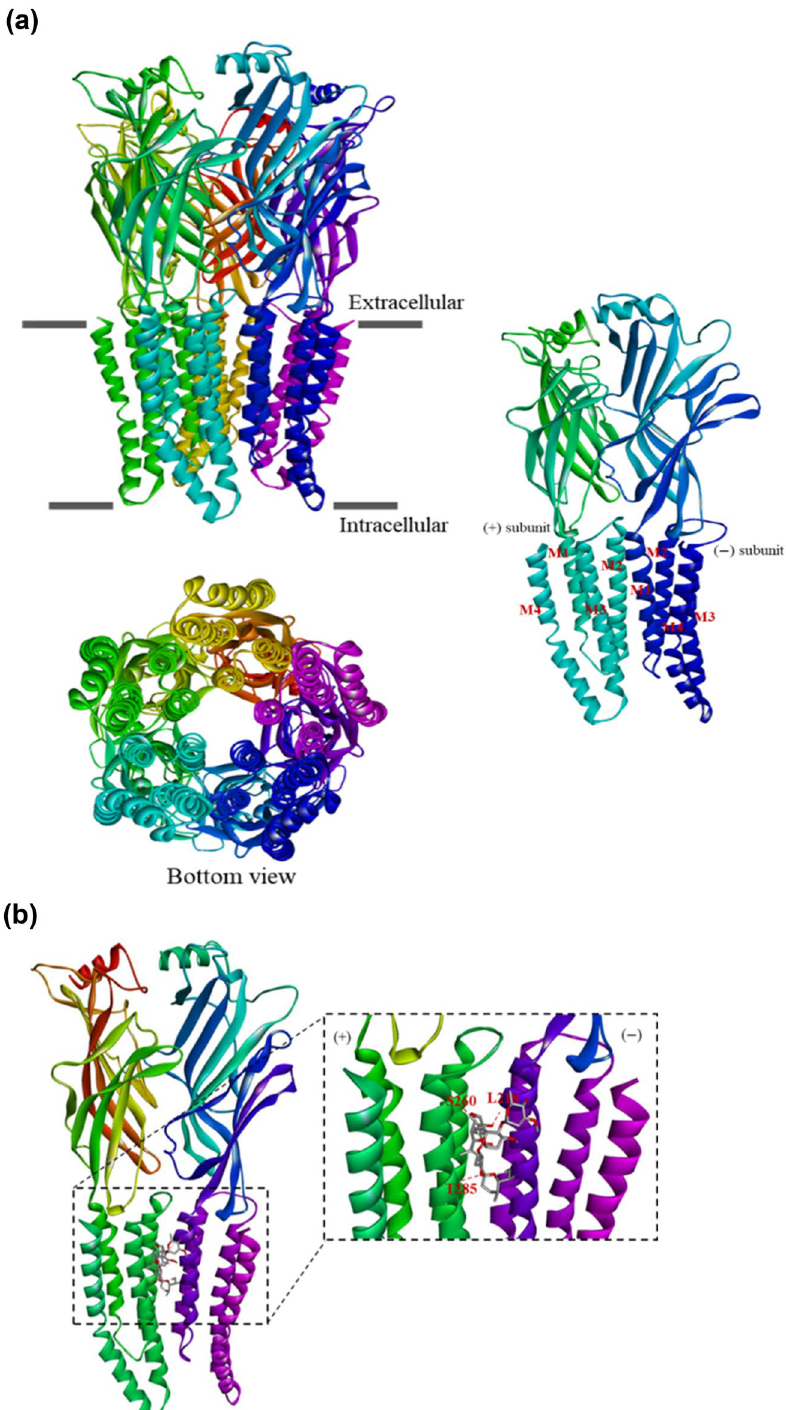
Figure 5. Molecular docking simulation of koranimine and ivermectin with Caenorhabditis elegans α GluCl receptor. ( a ) Three-dimensional (3D) protein model of C. elegans ivermectin-sensitive invertebrate α glutamate- gated chloride channel (GluCl) obtained from research collaboratory for structural bioinformatics protein data bank (RCSB PDB). ( b ) Best docking pose of ivermectin bound to the allosteric site of α GluCl receptor. ( c ). Ligand-receptor interactions between ivermectin- α GluCl receptor shown in 2D. ( d ) Best docking pose of koranimine bound to the allosteric site of α GluCl receptor. ( e ) Ligand-receptor interactions between koranimine- α GluCl shown in